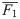
Results of the Friedman-Nemenyi test of classifiers ranking.The six classifiers are compared in terms of their ranking using two evaluation measures, Alpha (left) and F1¯ (right). The ranks of classifiers within the critical distance (2.09) are not statistically significantly different.